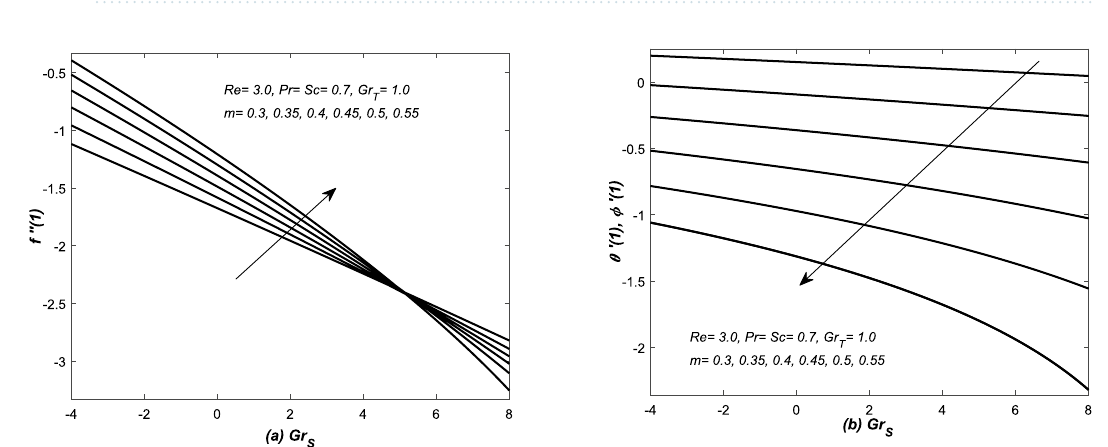
Figure 14. Converging channel: ( a ) Skin friction coefficient f ′′ ( 1 ) and ( b ) heat and mass transfer coefficients are plotted against solutal Grashof number Gr S and different values are assigned to the slope m .